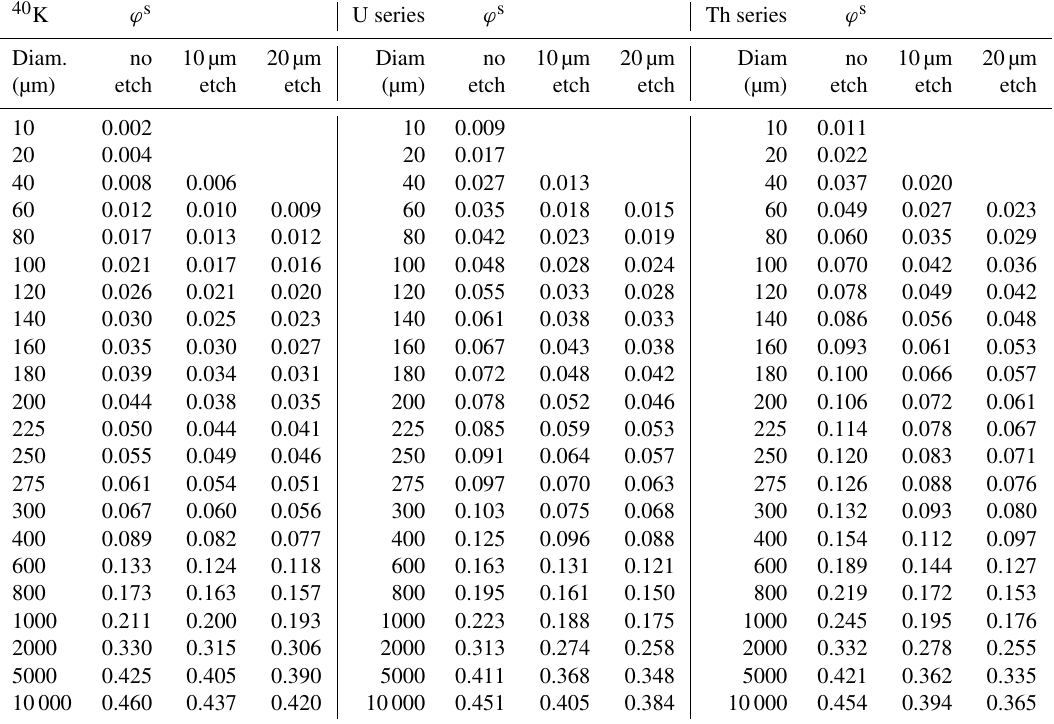
Table 2. Quartz self-dose values for surface sources, ϕ s